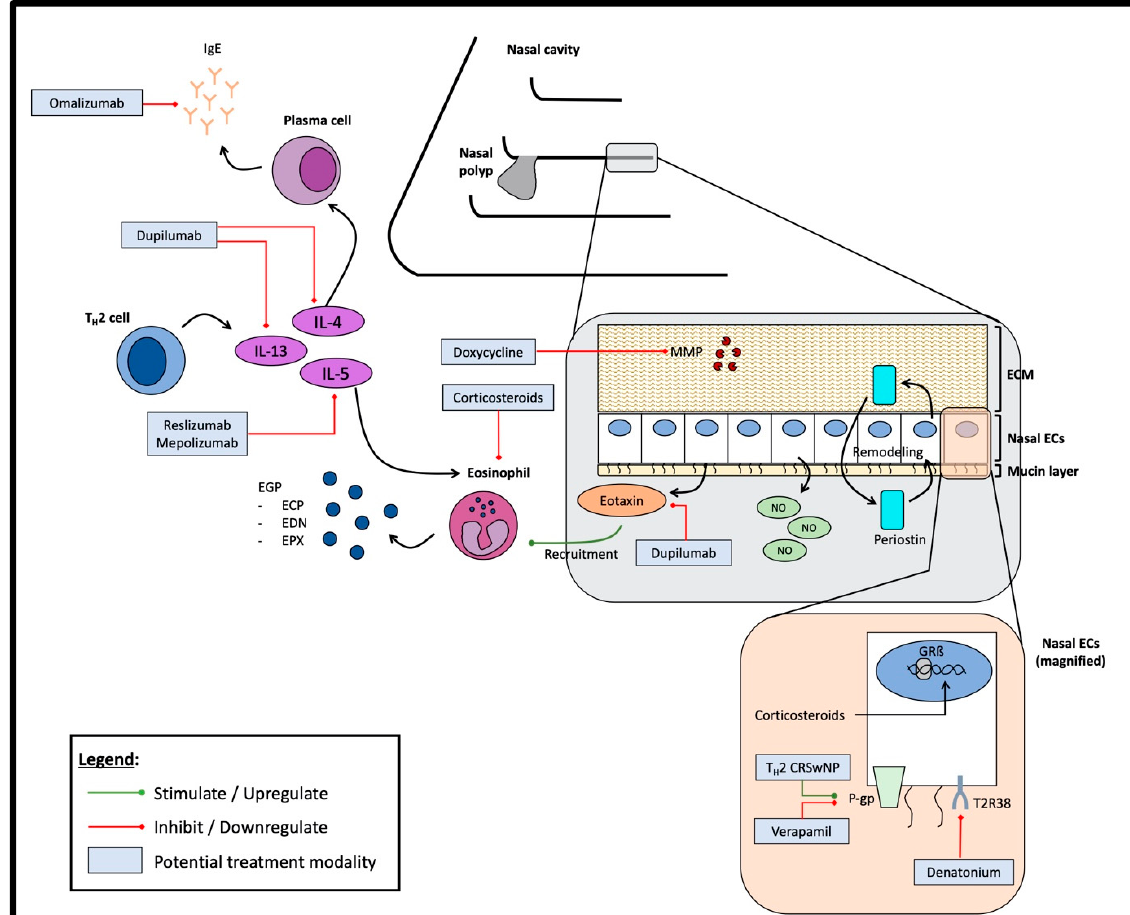
Figure 1. Interactions between various biomarkers in the pathomechanistic processes of different CRS subtypes, with various potential treatment modalities. IgE: Immunoglobulin E; EGP: Eosinophil granule protein; ECP: Eosinophilic cationic protein; EDN: Eosinophil-derived neurotoxin; EPX: Eosinophil peroxidase; MMP: Matrix metalloproteinase; ECM: Extracellular matrix; EC: Epithelial cells; P-gp: P-glycoprotein; NO: Nitric oxide; IL: Interleukin; GRß: Glucocorticoid receptor ß; T2R38: Taste receptor 2 member 38.